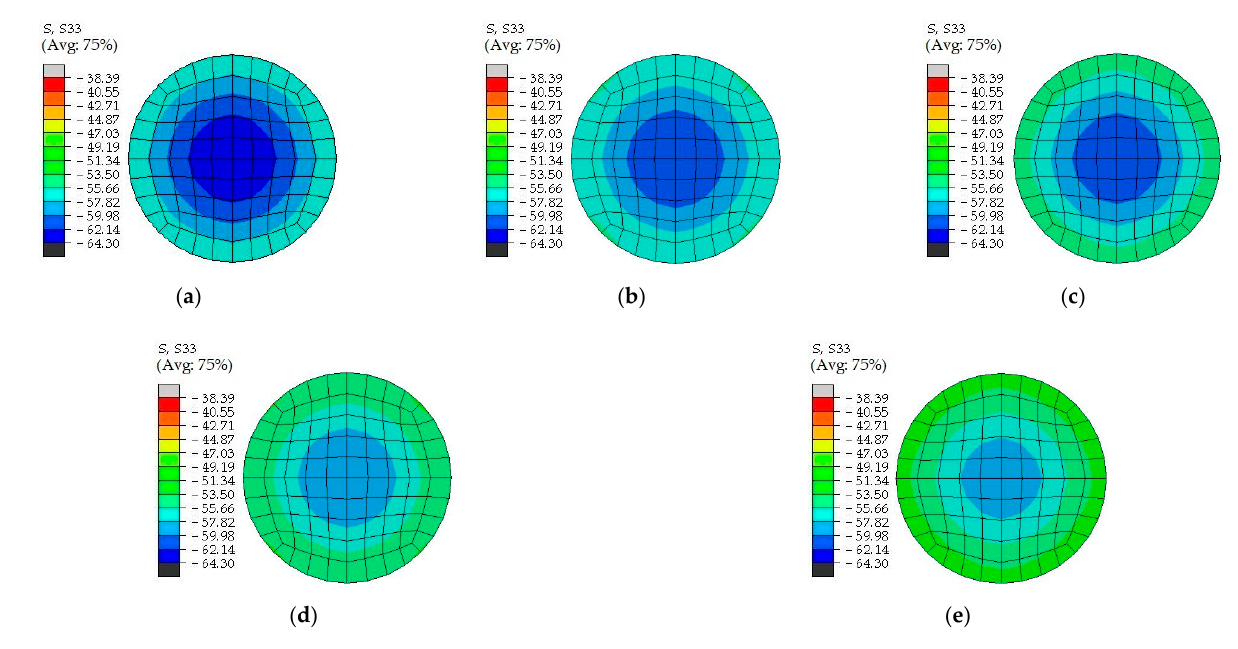
Figure 10. Comparison of stress nephogram of infilled concrete at the mid-section for CFCST and RACFCST stub columns: